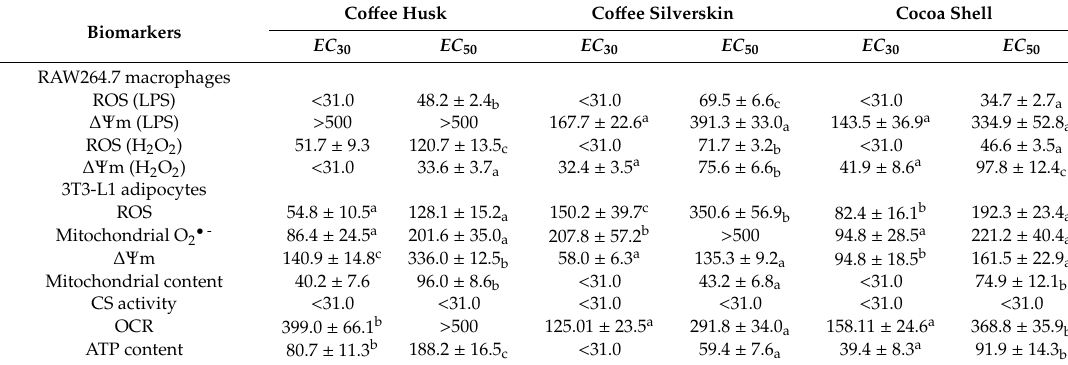
Table 3. Protective e ff ect of co ff ee husk, co ff ee silverskin, and cocoa shell extracts (31–500 µ g / mL) against oxidative stress and mitochondrial dysfunction regulating ROS and ∆Ψ m in RAW264.7 macrophages and ROS, mitochondrial O 2 • - , ∆Ψ m, mitochondrial content, citrate synthase (CS) activity, oxygen consumption rate (OCR), and ATP content in 3T3-L1 adipocytes. Values are expressed as mean ( µ g / mL) ± SD ( n = 3). Di ff erent letters among rows indicate significant di ff erences ( p < 0.05) according to ANOVA and Tukey’s multiple range